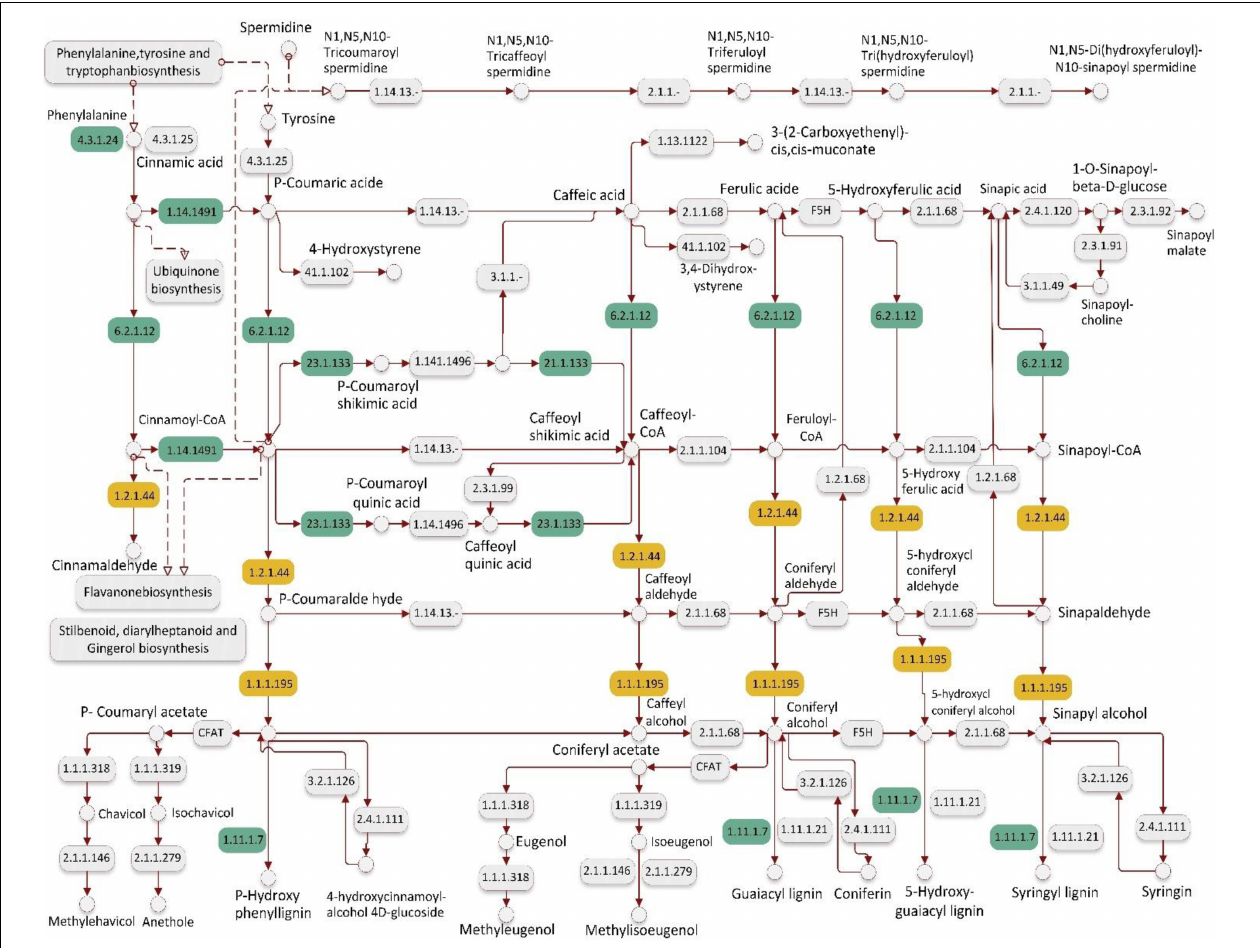
FIGURE 4 | Phenylpropanoid biosynthesis pathway detected in response to salt stress conditions (300 mM NaCl) in barley. This figure represents only one of the KEGG pathway for up-regulated genes in the salt-tolerant and salt-sensitive genotypes. Green color boxes represent the differentially expressed genes (DEGs) in salt-tolerant genotype and yellow color boxes represent the specifically DEGs in salt-sensitive genotype. EC number of the encoded enzyme is shown in each box, e.g., [EC:4.3.1.24]: phenylalanine ammonia-lyase (PAL), [EC:1.14.14.91]: trans -cinnamate 4-monooxygenase (CYP73A), [EC:6.2.1.12] 4-coumarate–CoA ligase (4CL), [EC:2.3.1.133]: shikimate O -hydroxycinnamoyltransferase (HCT), [EC:1.11.1.7]: peroxidase [EC:1.2.1.44]: cinnamoyl-CoA reductase (CCR), [EC:1.1.1.195]: cinnamyl-alcohol dehydrogenase